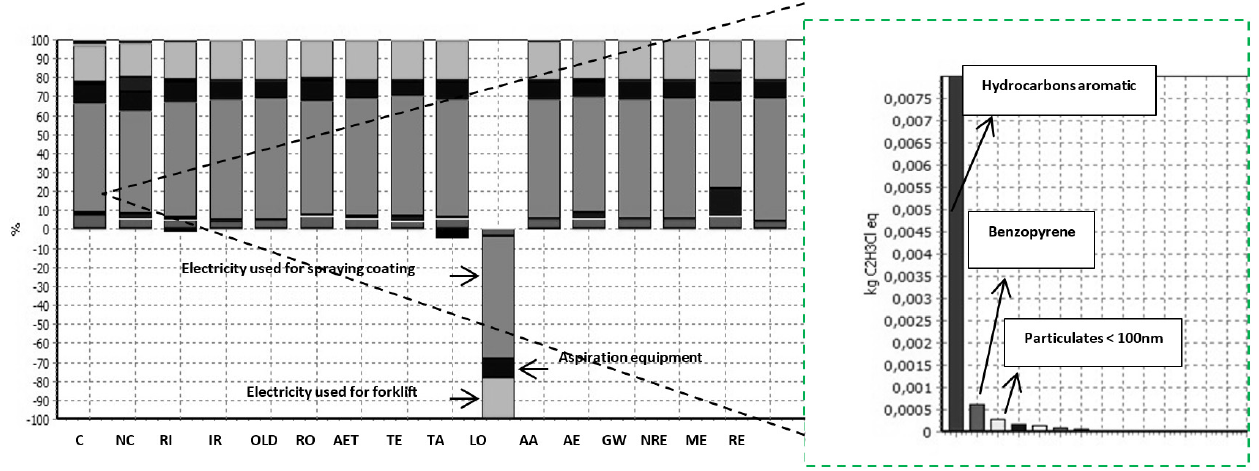
Figure 2. Evaluation by impact category of 1 m 2 of nano-TiO 2 coating on travertine, where: C = carcinogens; NC = non-carcinogens; RI = respiratory inorganics; IR = ionizing radiation; OLD = ozone layer depletion; RO = respiratory organics; AET = aquatic ecotoxicity; TE = terrestrial ecotoxicity; TA = terrestrial acid/nutria; LO = land occupation; AA = aquatic acidification; AE = aquatic eutrophication; GW = global warming; NRE = non-renewable energy; ME = mineral extraction. The details of the contribution of the emissions to the air for the carcinogens impact category are also